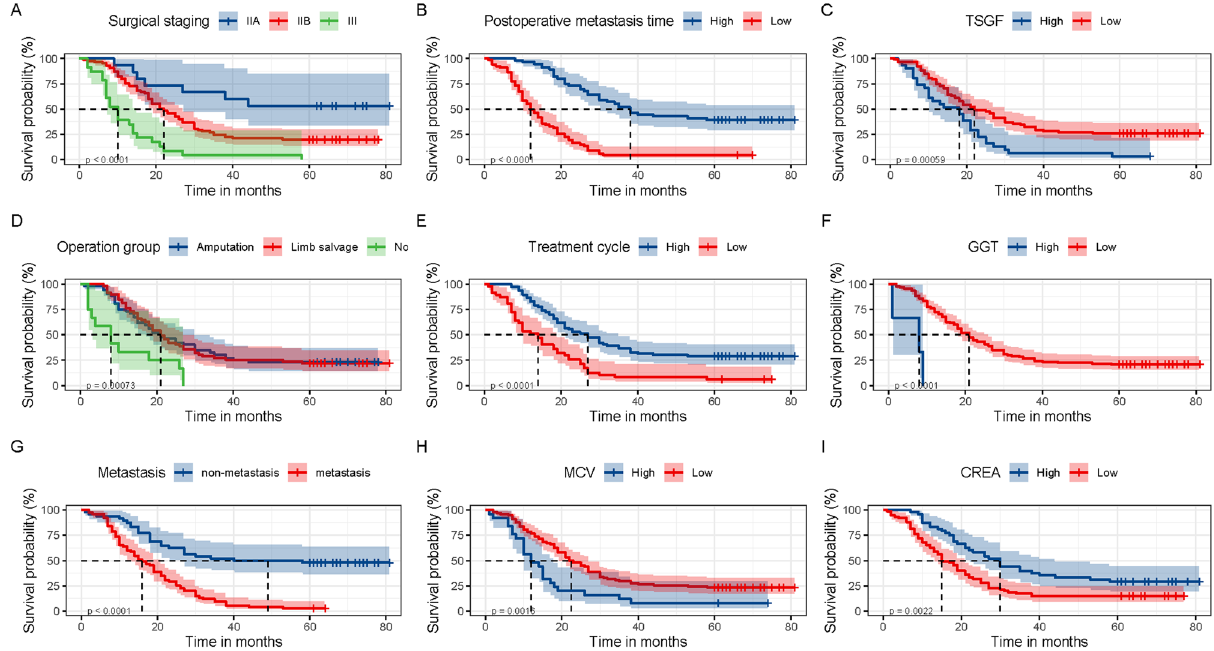
Figure 1. Kaplan–Meier survival curves of tumour-related survival for significant factors in univariate and multivariate Cox proportional regression models. Kaplan–Meier curves of tumour-related survival according to the surgical staging ( A ), postoperative metastasis time ( B ), TSGF group ( C ), operation group ( D ), treatment cycle ( E ), GGT group ( F ), metastasis group ( G ), MCV group ( H ), and CREA group ( I ). A log-rank p value <